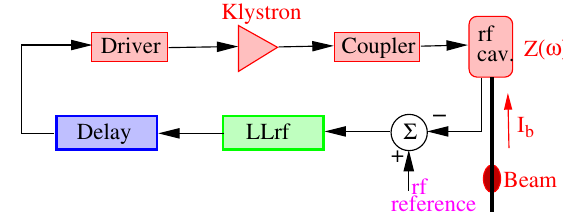
FIG. 1. Rf loop model block